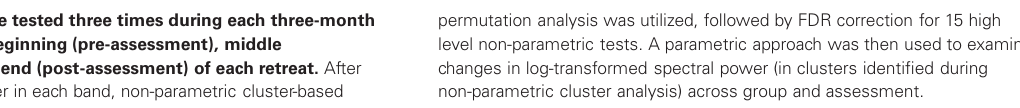
permutation analysis was utilized, followed by FDR correction for 15 high level non-parametric tests. A parametric approach was then used to examine changes in log-transformed spectral power (in clusters identified during non-parametric cluster analysis) across group and